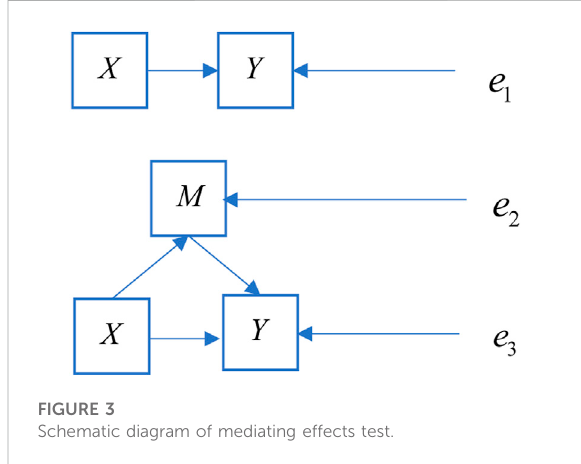
FIGURE 3 Schematic diagram of mediating effects